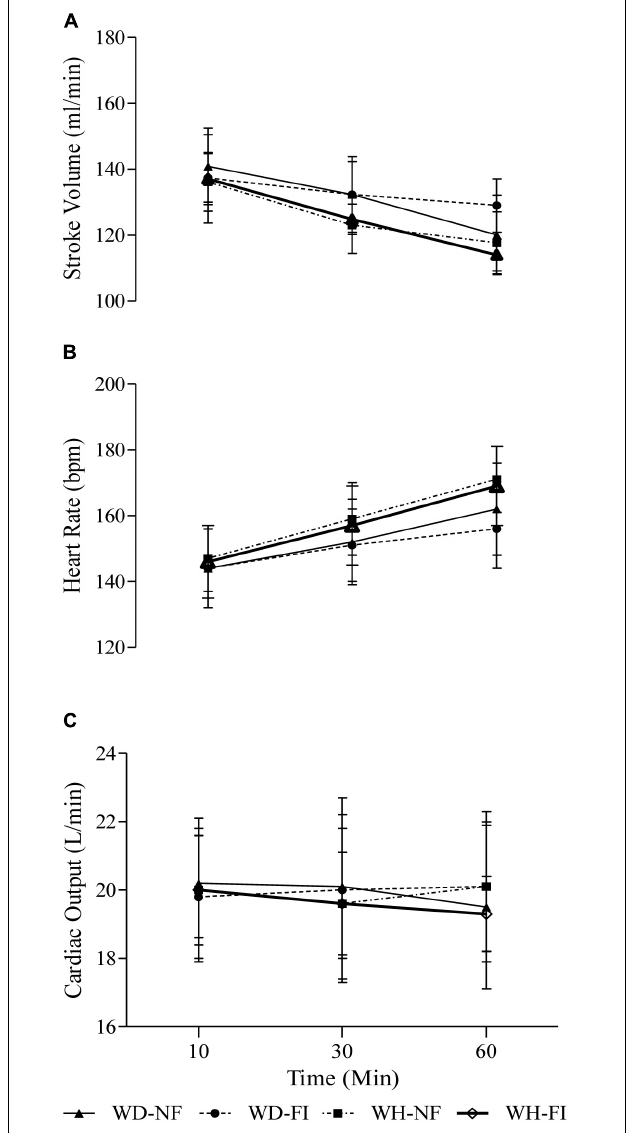
FIGURE 2 | Stroke volume (A) , heart rate (B) , and cardiac output (C) during the steady state exercise in the fluid ingestion (FI) and non-fluid ingestion trial (NF) in a warm-dry (WD) and warm-humid (WH) condition.